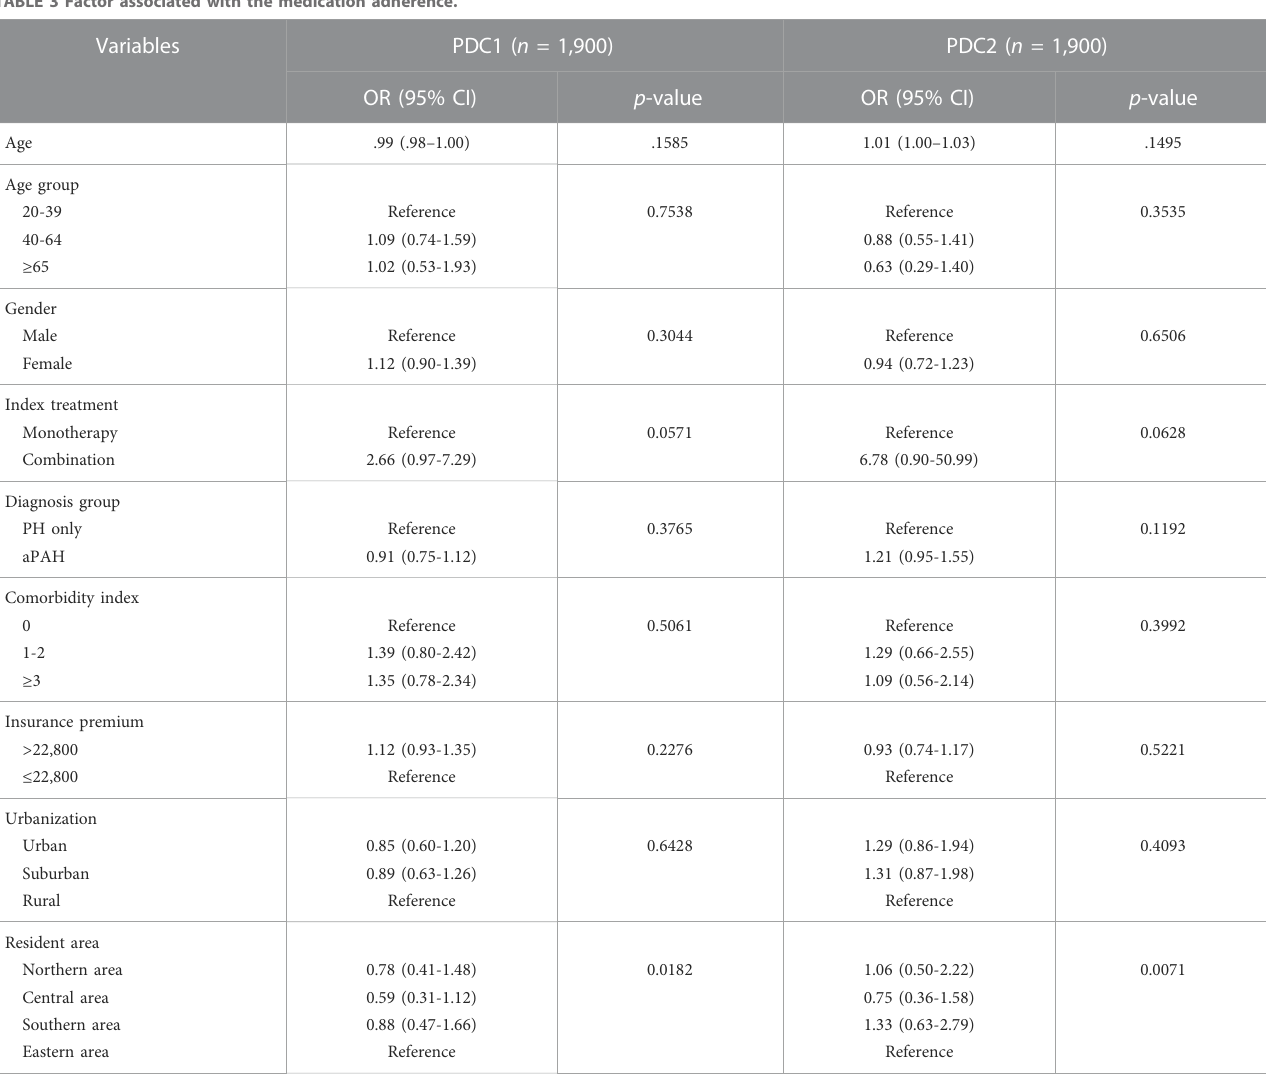
TABLE 3 Factor associated with the medication